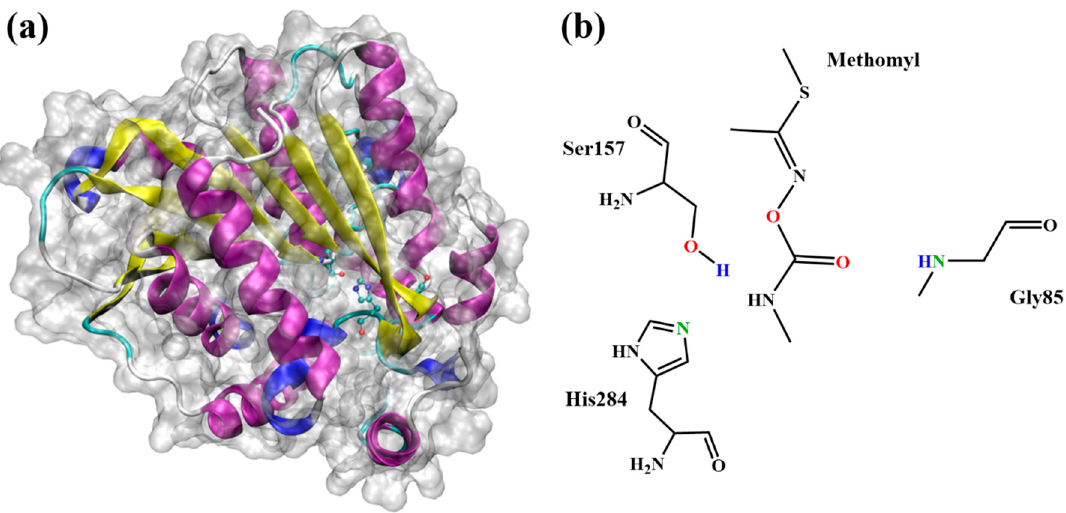
Figure 1. ( a ) Structural diagram of secondary structure of esterase PestE. ( b ) The chemical structure of methomyl and a representation of QM region.